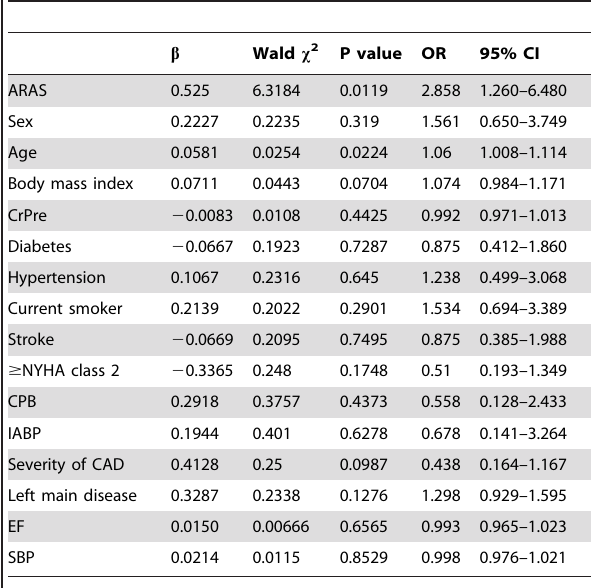
Table 3. Multiple Logistic Regression Adjusted by Propensity Scores.